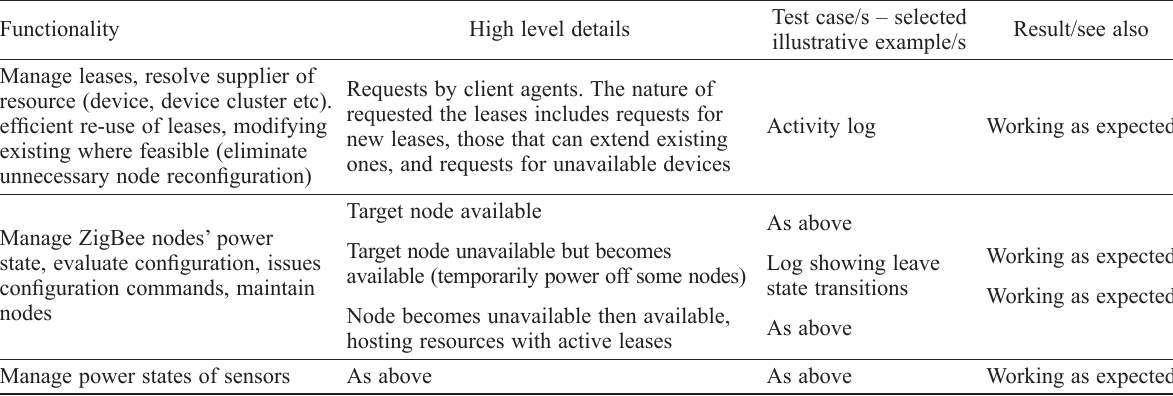
Table 6. some sensor node agent type